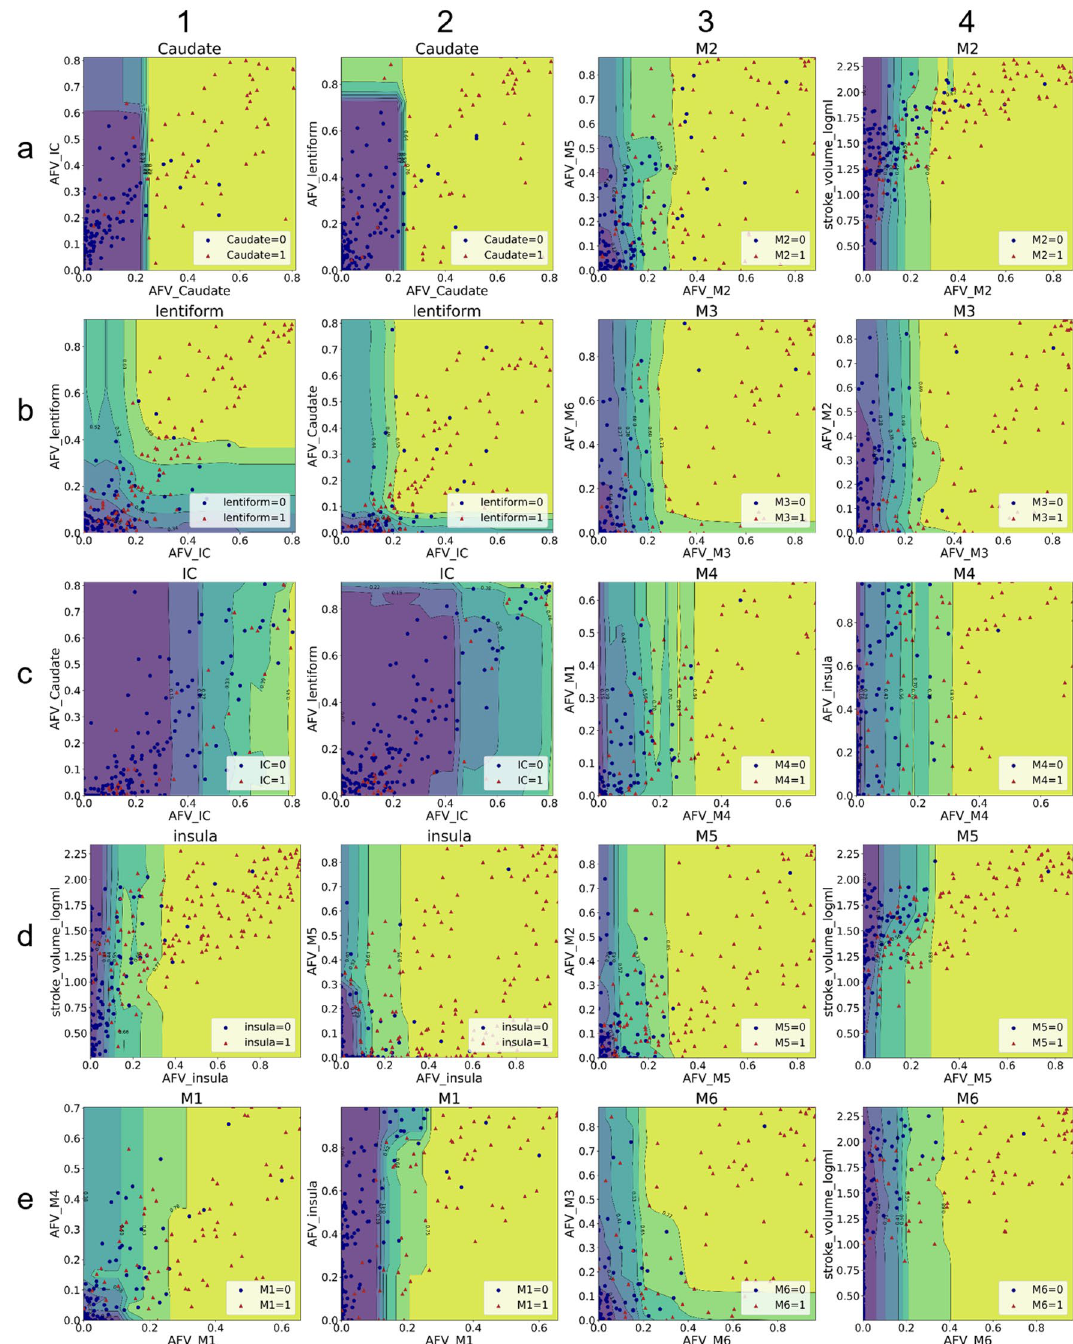
Figure 7. Partial dependent plots (PDPs) showing the top 3 features of Random Forest (RF) models for each ROI. The PDPs indicate the average marginal effect of the AFV on classifying each ROI (title of each graph) in infarcted (1) or not infarcted (0). As the three most important features are shown, each region is represented by a pair of graphics in which the x-axis shows the most important classification feature and the y-axis shows the second and third, respectively. The colors show the topology of the probabilistic classification. For example, top left graphic shows that caudate usually scores "1" (i.e., infarcted) if above 25% of its volume is occupied by the infarct mask (red dots in the yellow area). However, even if caudate injury is below this level, a case may score "1" if the neighboring lentiform is highly affected (> 80%; red dots in the green area). This indicates that, similarly to humans, AI uses a more complex classification approach than the single binary threshold of injury for the region in question to determine